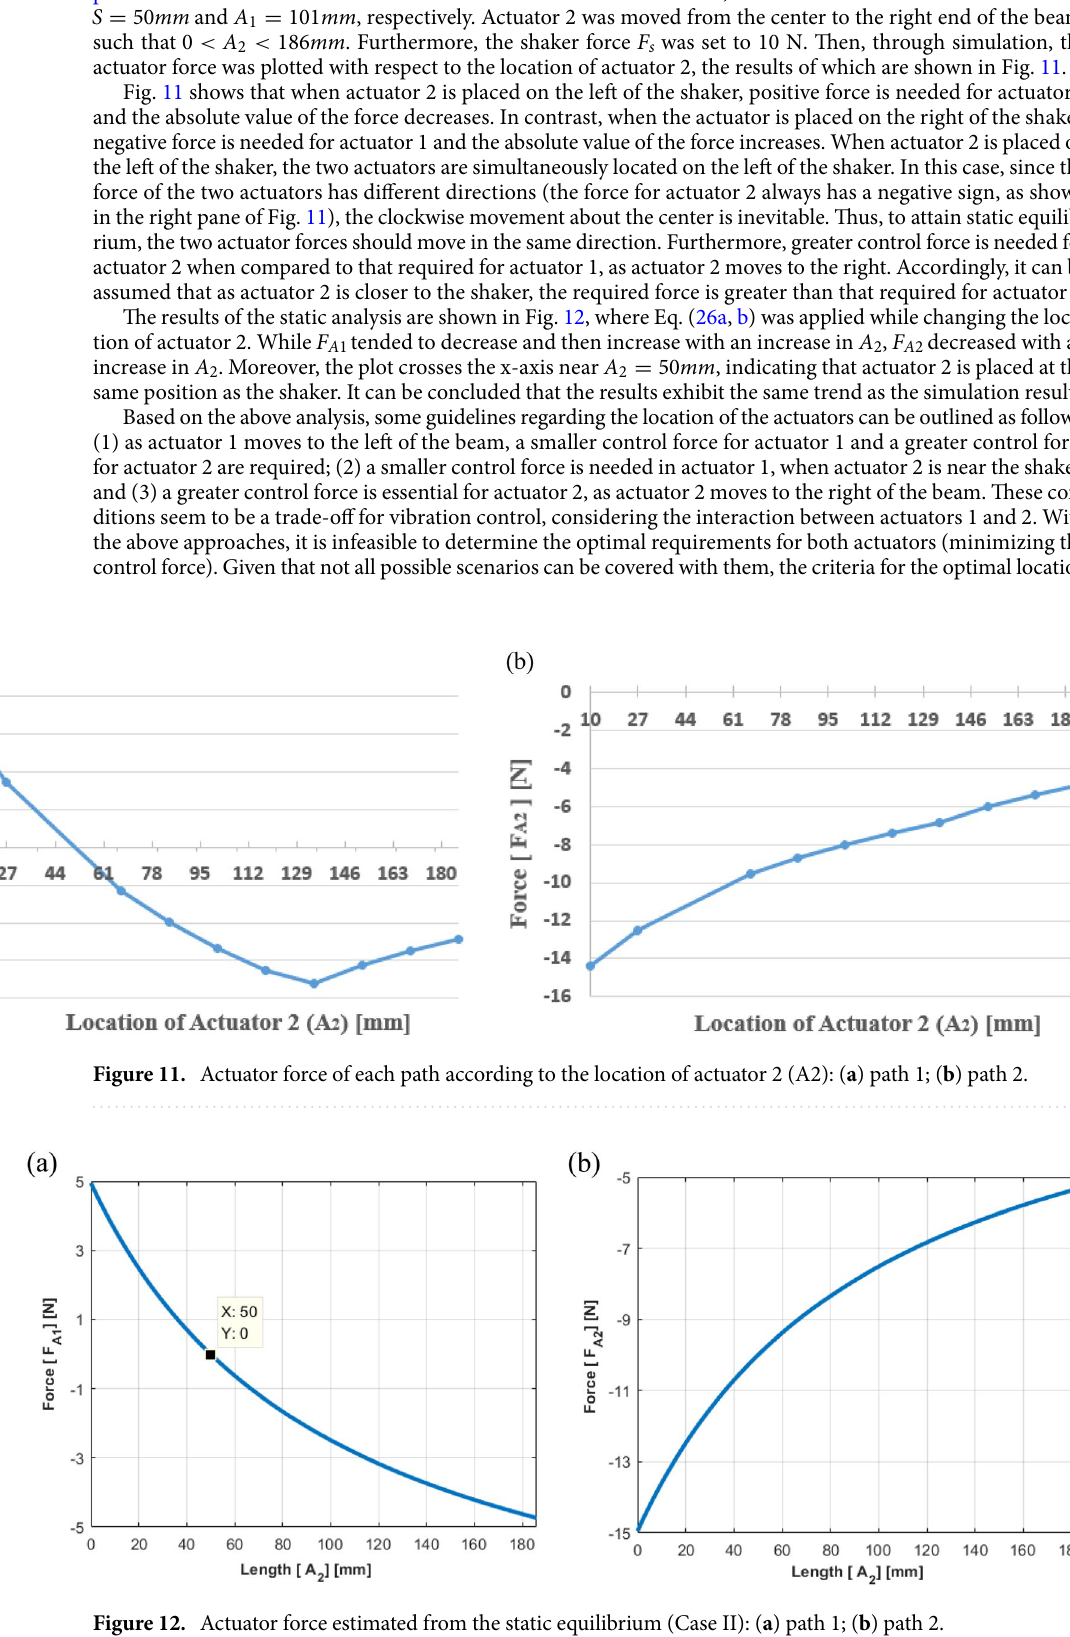
Figure 12. Actuator force estimated from the static equilibrium (Case II): ( a ) path 1; ( b ) path